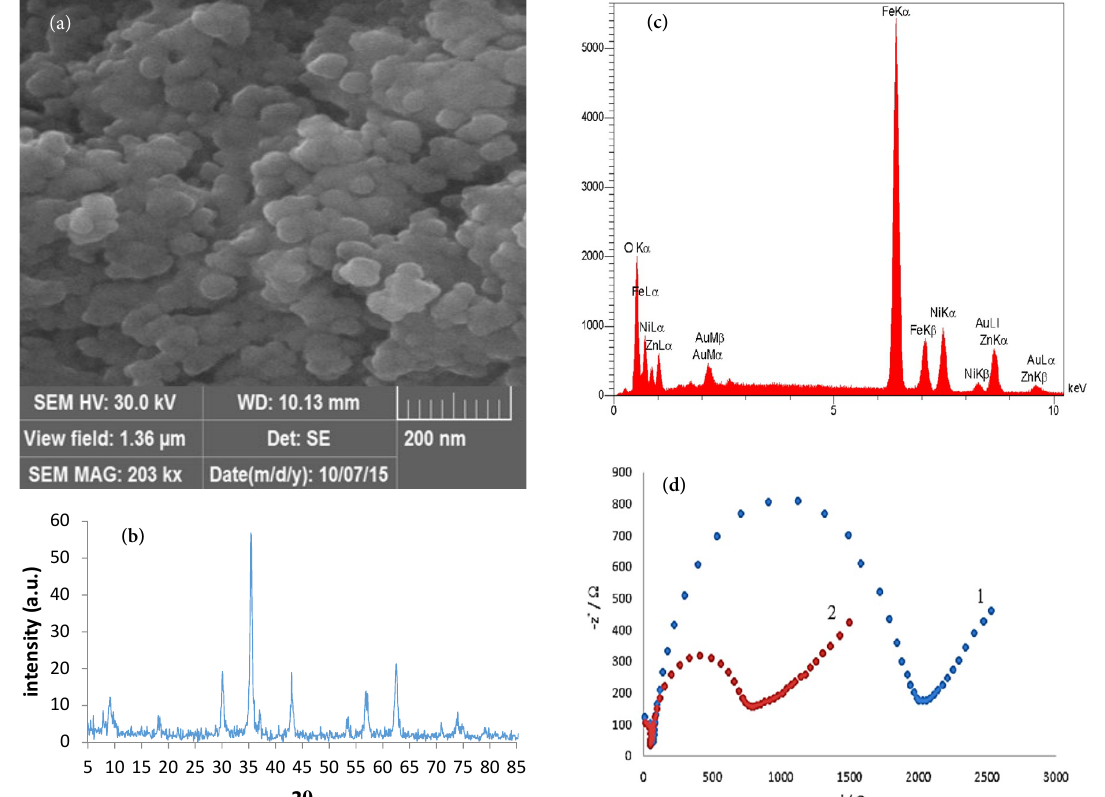
Fig. 1. SEM image for Ni Ni Zn Fe O nanocomposite (c) and Nyquist plots of 5.0 mmol L -1 Fe (CN) 63− / Fe(CN) 64− containing 0.1 mol L -1 KNO 0.5 0.5 2 4